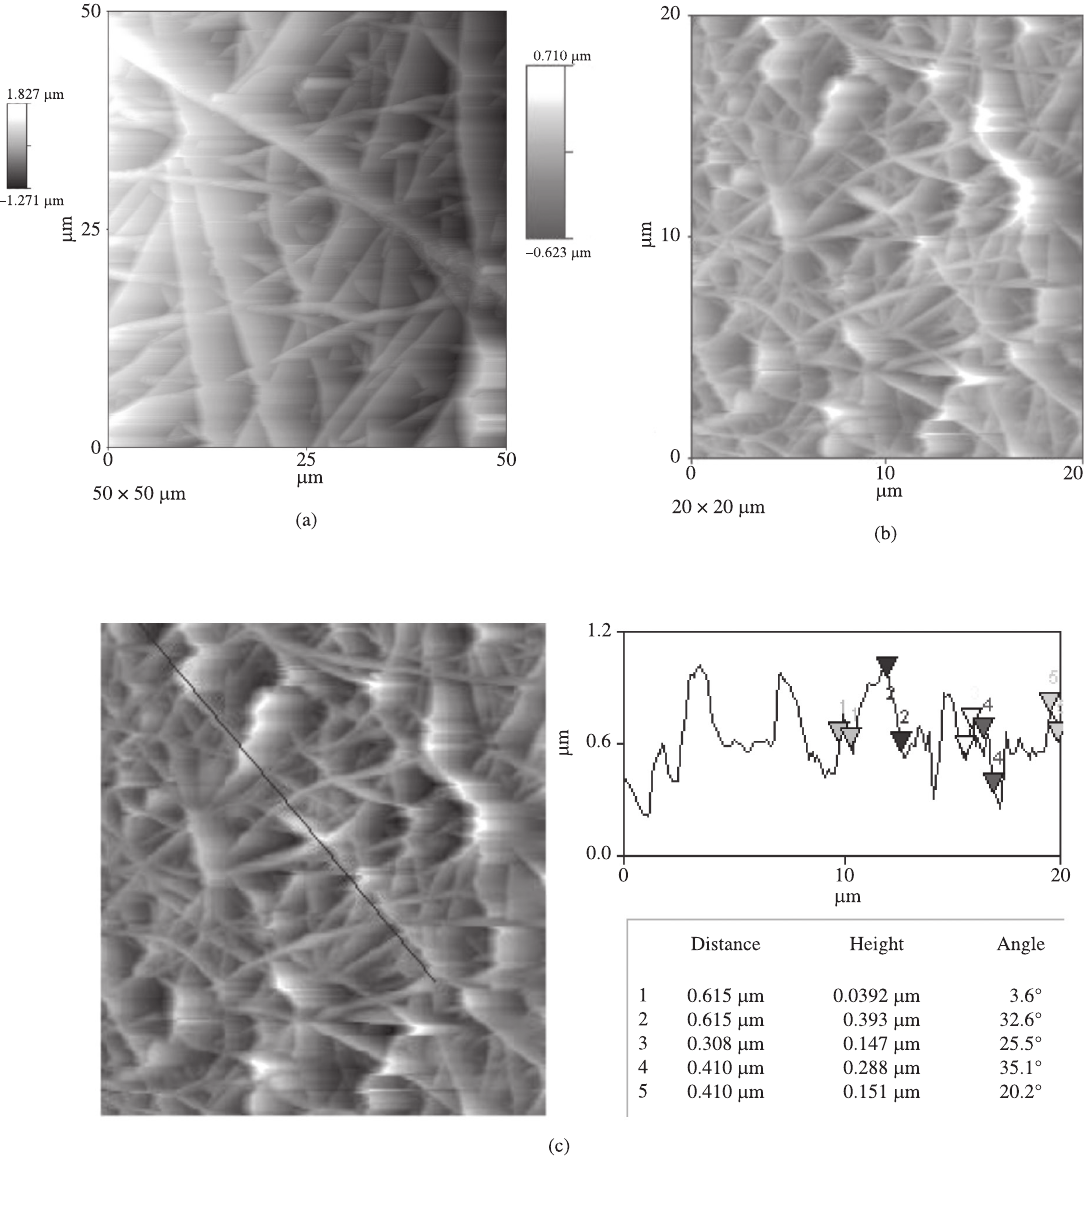
Figure 4. AFM images of electrospun PVA